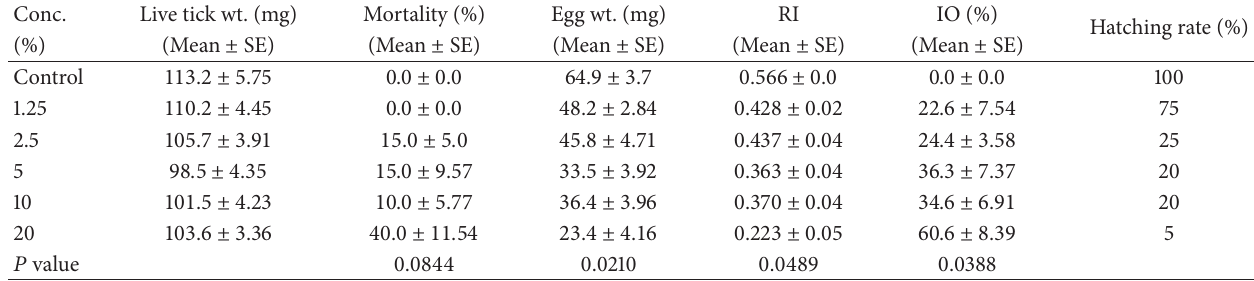
Table 1: Tick weight, percent mortality, egg weight, reproductive index (RI), and inhibition of oviposition (IO) of R. microplus adults exposed to different concentrations of A. conyzoides . Conc.